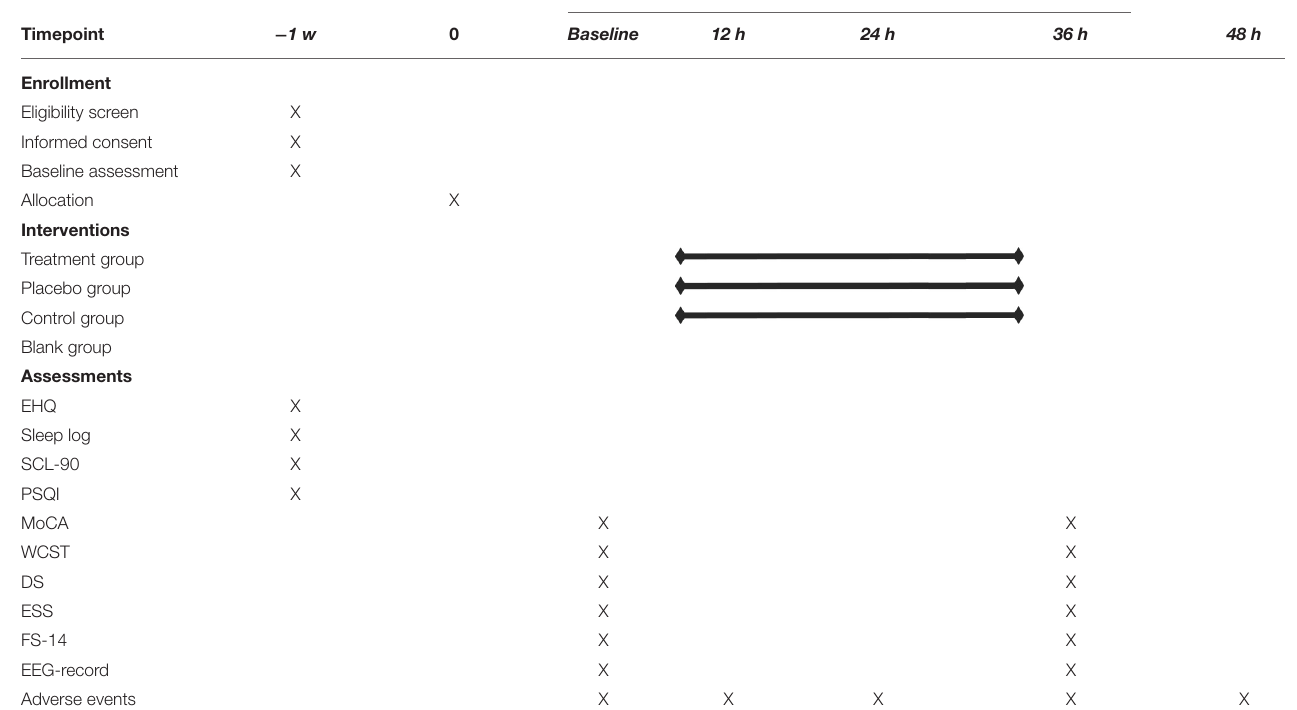
TABLE 1 | SPIRIT figure for schedule of enrollment, interventions and assessments. Study Period Enrollment Allocation Post-allocation